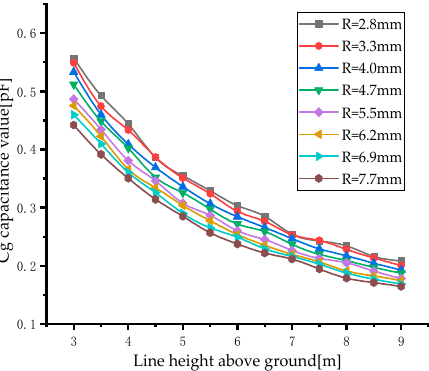
Figure 4. Influence of Line Radius and Height from Ground on Capacitor C l .